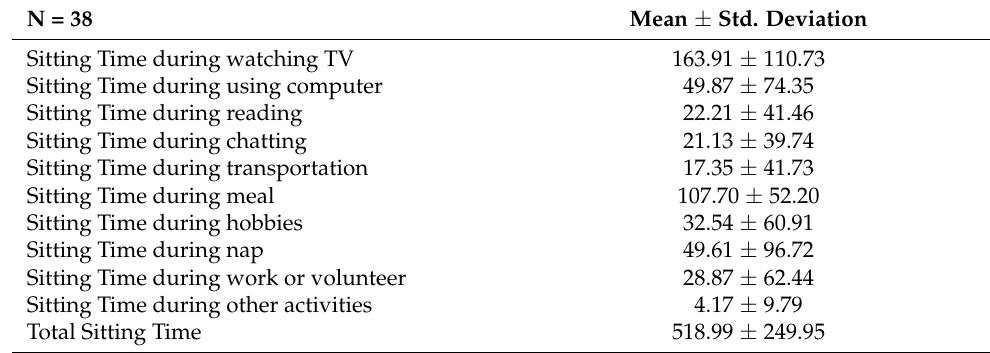
Table 4. Descriptive statistics of the average minutes spent in different sedentary domains from the Sedentary Behaviour Questionnaire for Older